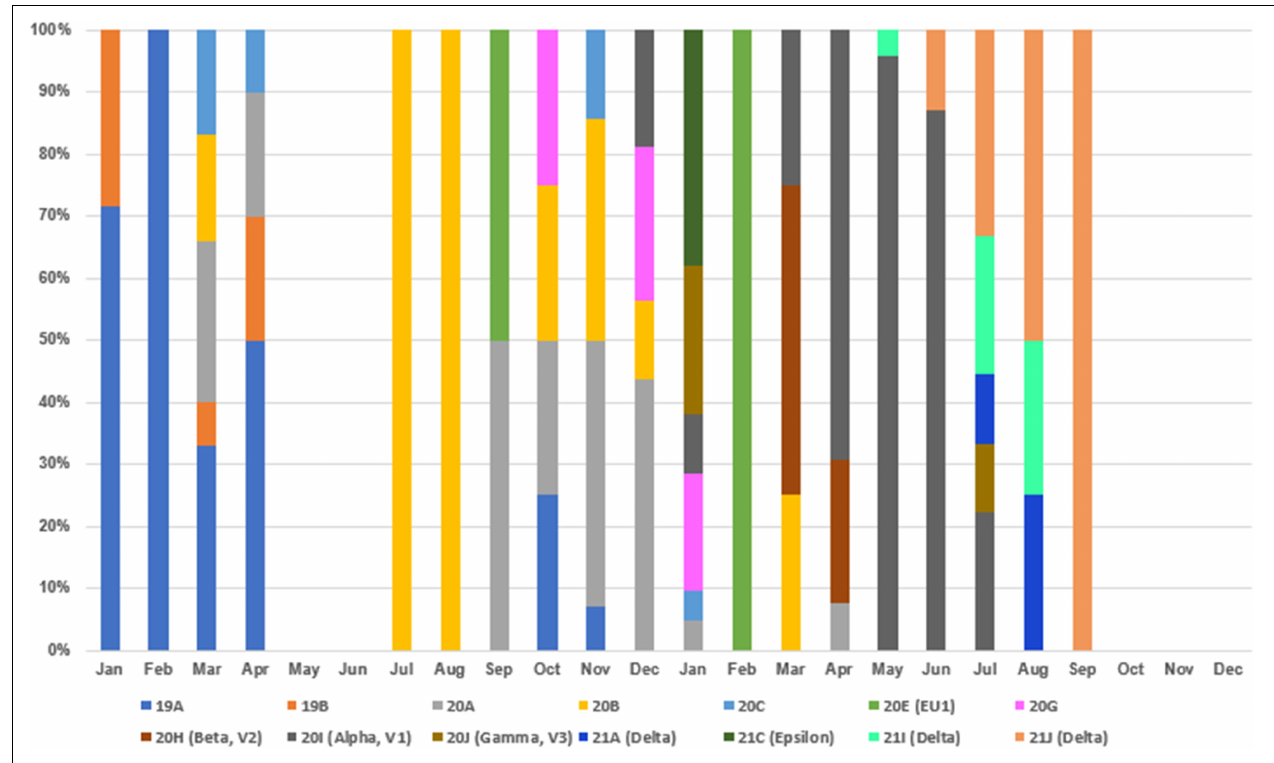
FIGURE 4 | Clades replaced over time between January 2020 and December 2021 in Taiwan.